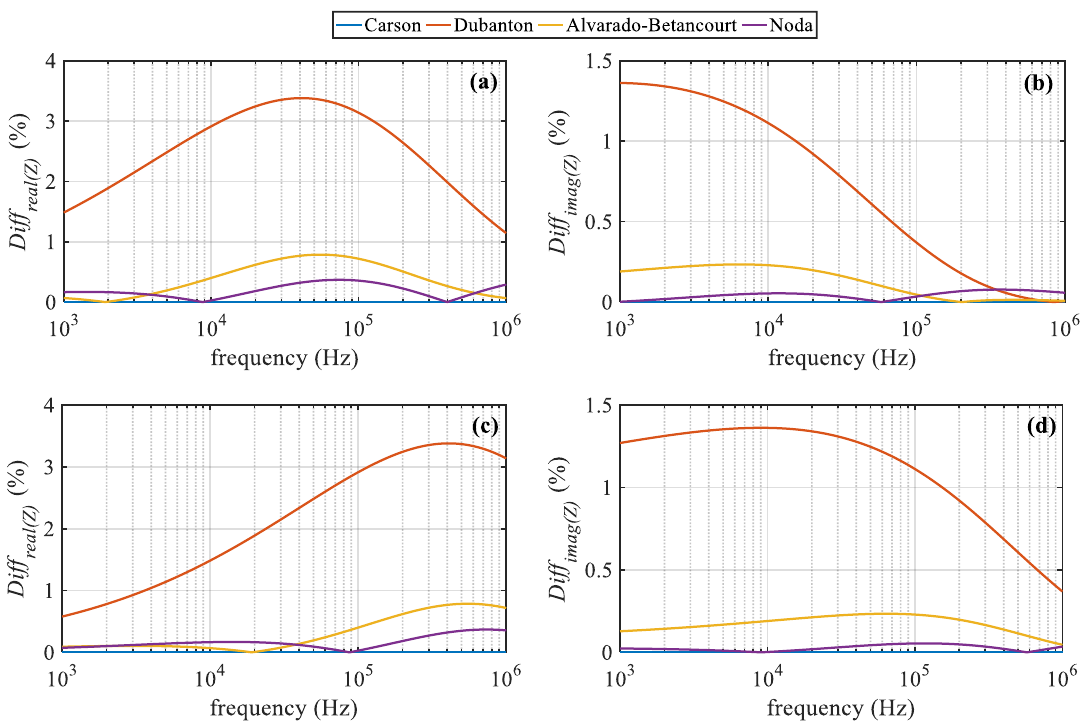
Figure 6. Differences in Z 11 in BB. F or ρ g = 100 Ωm, ε rg = 1 and ( a ) real part, ( b ) imaginary part, for ρ 1 = 1000 Ωm, ε rg = 1 and ( c ) real part, ( d ) imaginary part.